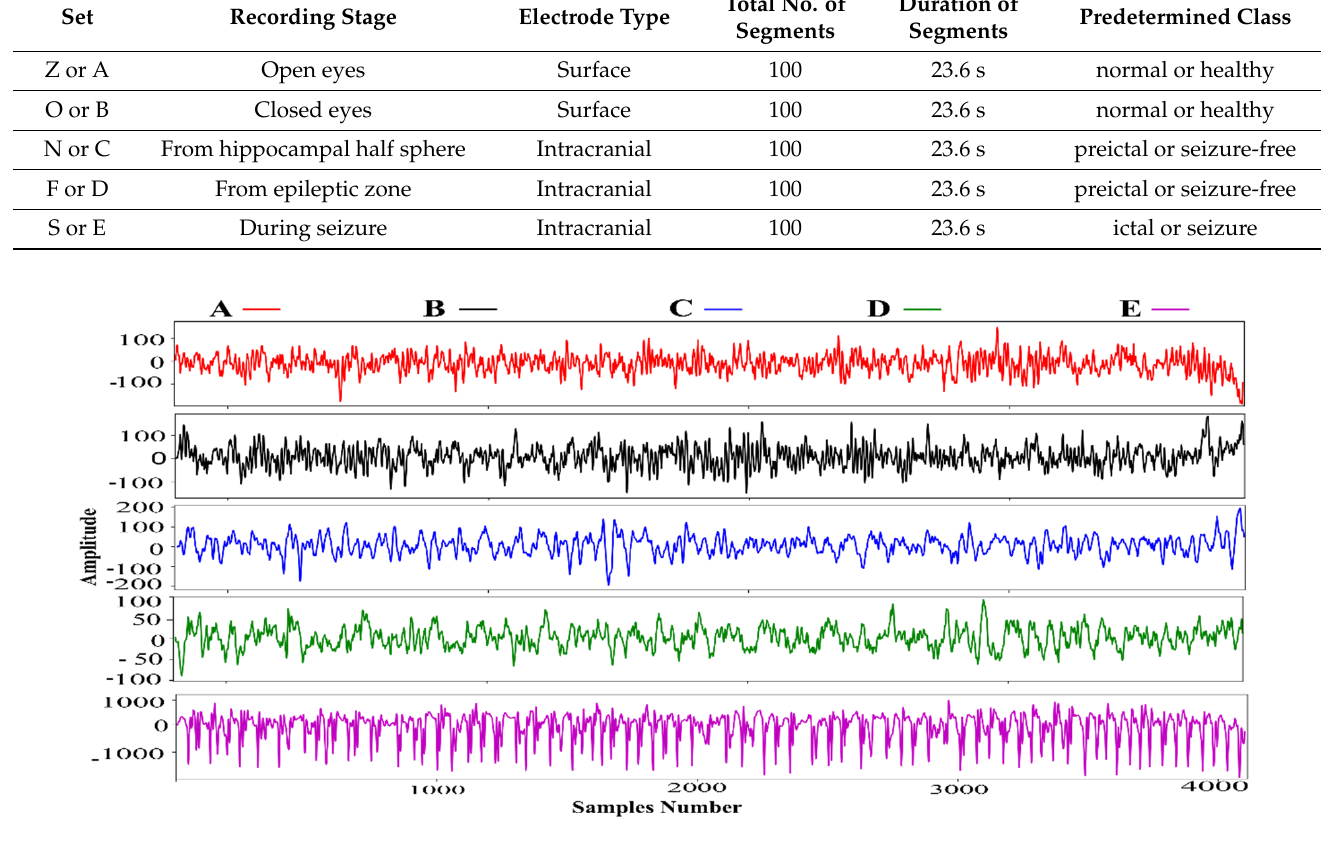
Figure 1. Single sample of each subset (A–E).